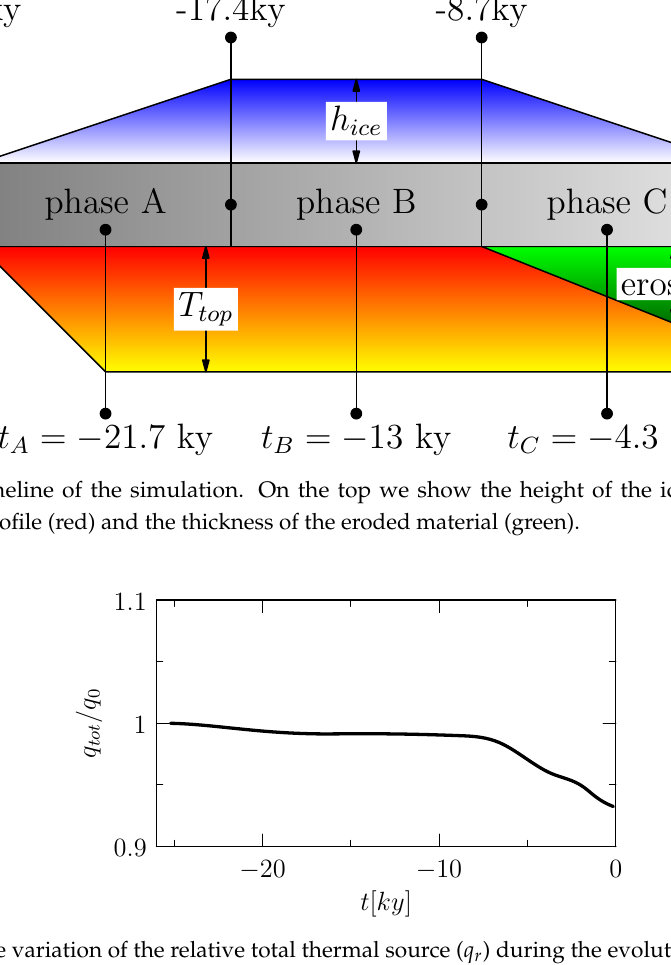
Figure 11. Time variation of the relative total thermal source ( q r ) during the evolution of the domain because of isostasy and